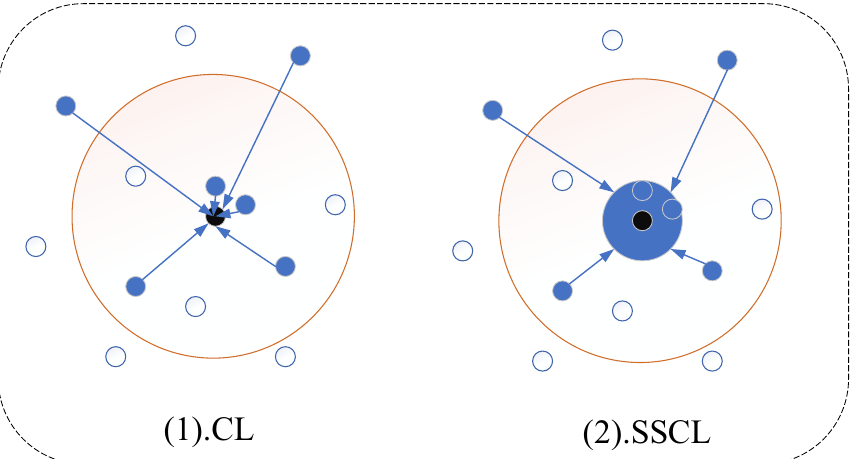
Figure 5. Two loss functions. The blue dots indicate that similar objects need to be as close as possible in the metric space, and the black dots indicate the ideal class center representation. (1) denotes the traditional contrast loss, which requires the objects with high similarity to be brought infinitely close. (2) denotes our proposed soft similarity contrast loss, which stops over-optimization when the high similarity ones are brought closer to a higher threshold to speed up the convergence rate.